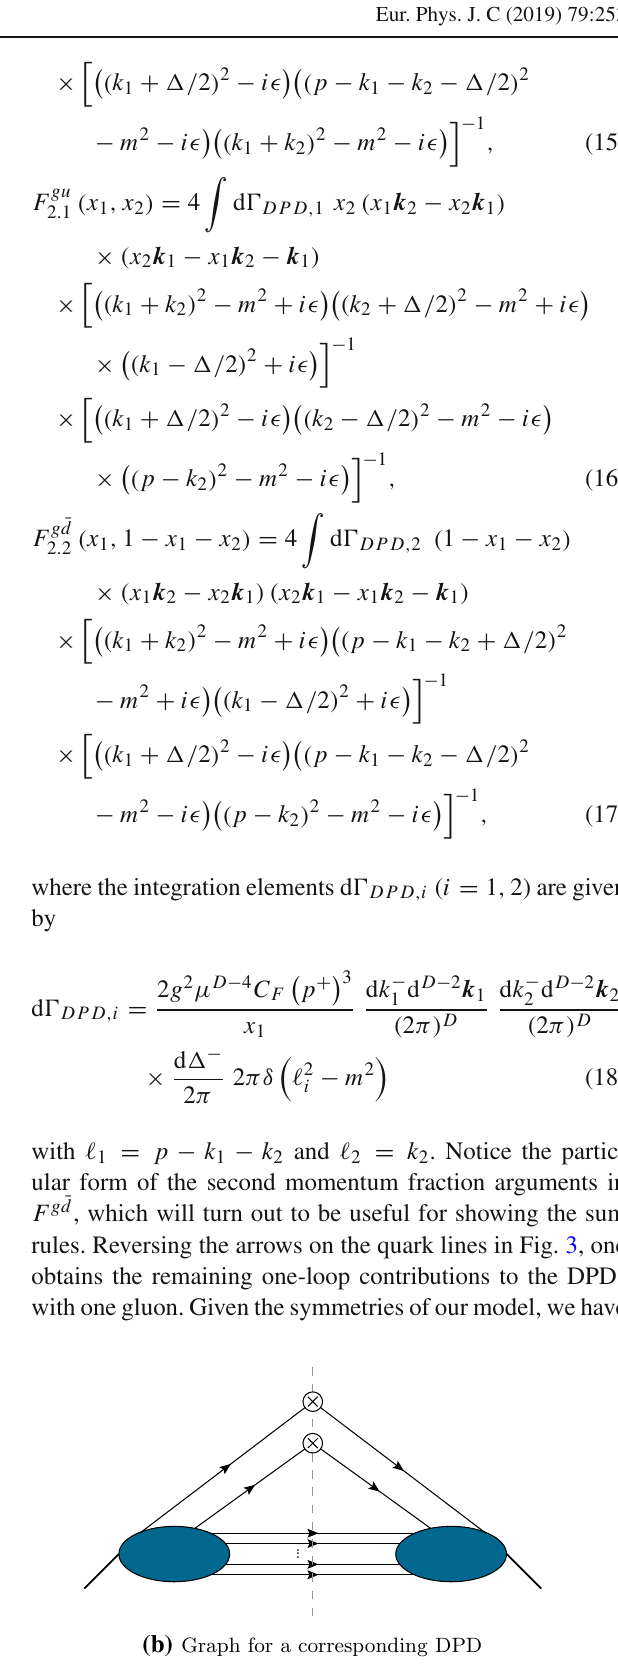
Fig. 2 Transition from a given PDF graph to a corresponding DPD